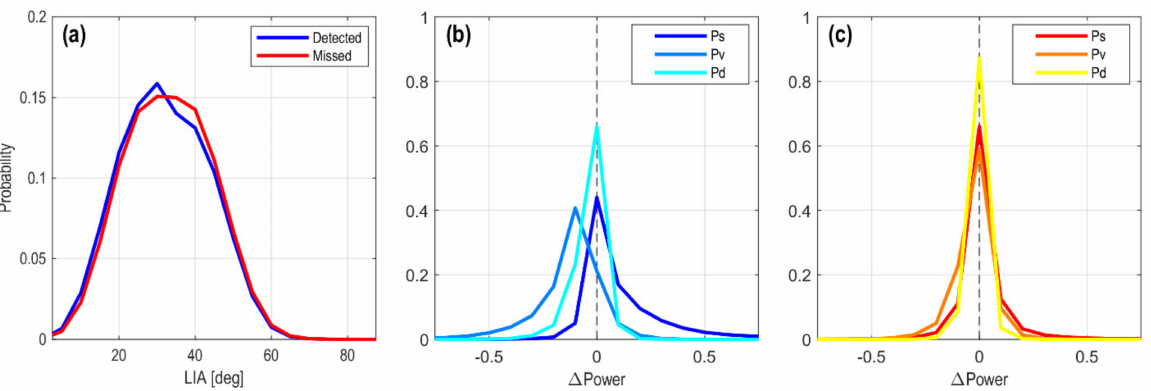
Figure 12. Normalized histogram for ( a ) the LIA and the post-to-pre-event difference in scattering powers ( ∆ Power) for the ( b ) detected and ( c ) missed pixels in the L-band quad-pol datatype (detected and missed pixels are based on the GSBA binary map generated with the P c Z-score map). The histograms are computed over the entire Hokkaido